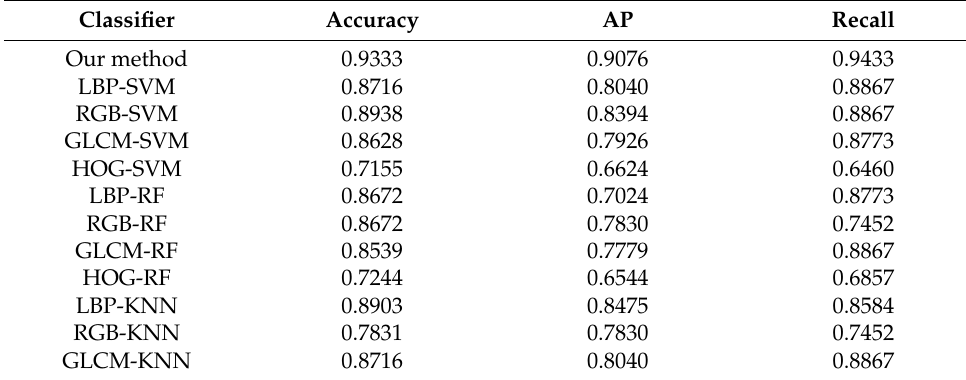
Table 1. Compared with single image feature classifier.